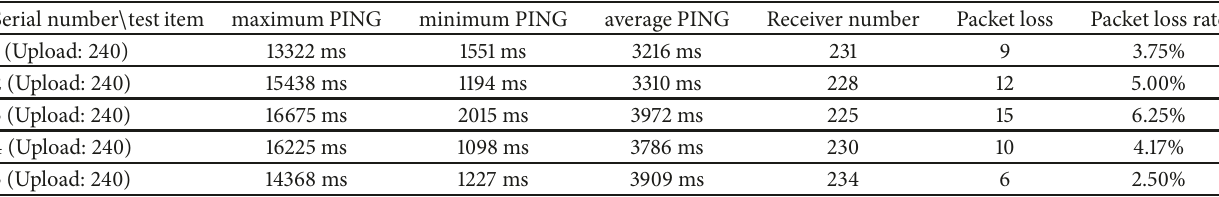
Table 1: Data upload test